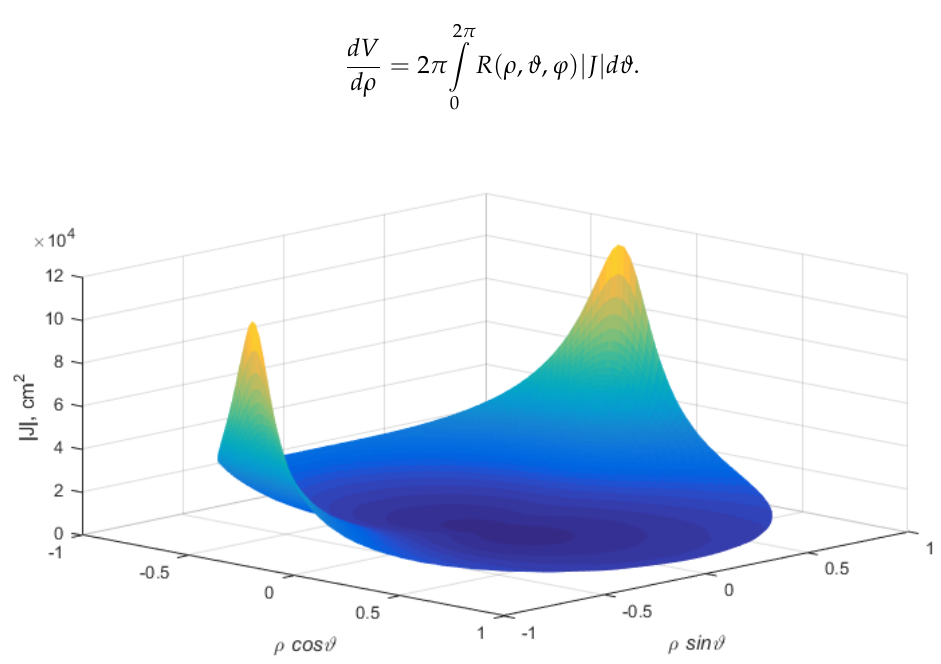
Figure 6. Jacobian determinant (24) for a candidate regime of DEMO-FNS. The coordinate transformation procedure is involved in such A 3D mesh in Figure 7 (a) illustrates the last closed flux surface corresponding to the normalised poloidal radius 1 = . The three lines in Figure 7 (a) show three different injection directions corresponding to three different values of tangency radius. The values of the effective radius (dashed lines) and the angle (solid lines) between the injection line and the magnetic field vector are shown in Figure 7 (b) for each of the injection lines by the corresponding colours. The radial profiles of the plasma parameters used in calcula-